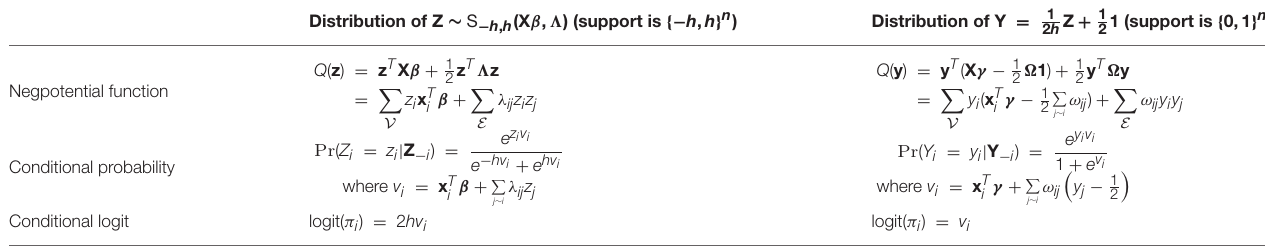
TABLE 2 | Model formulae for the symmetric ALR model, in two forms. Distribution of Z ∼ S − h , h (X β , 3 ) (support is {− h , h } n